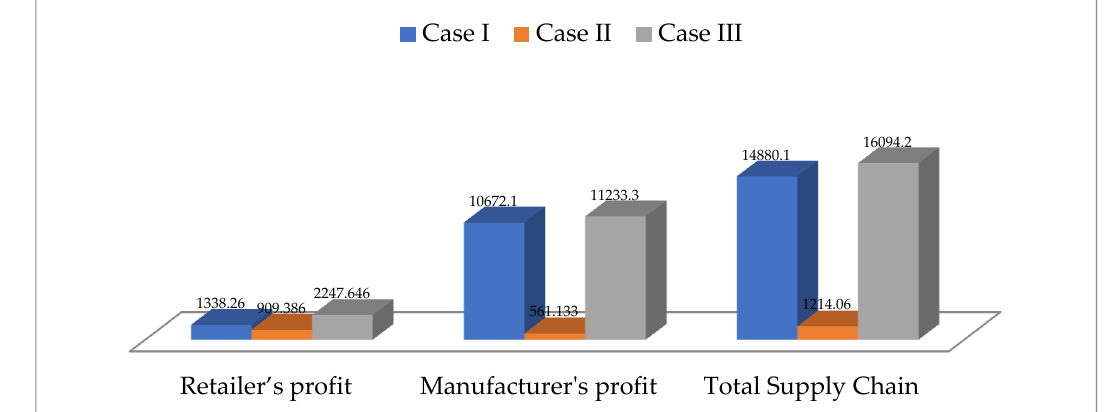
Figure 4. Offline situation measures under three policies.